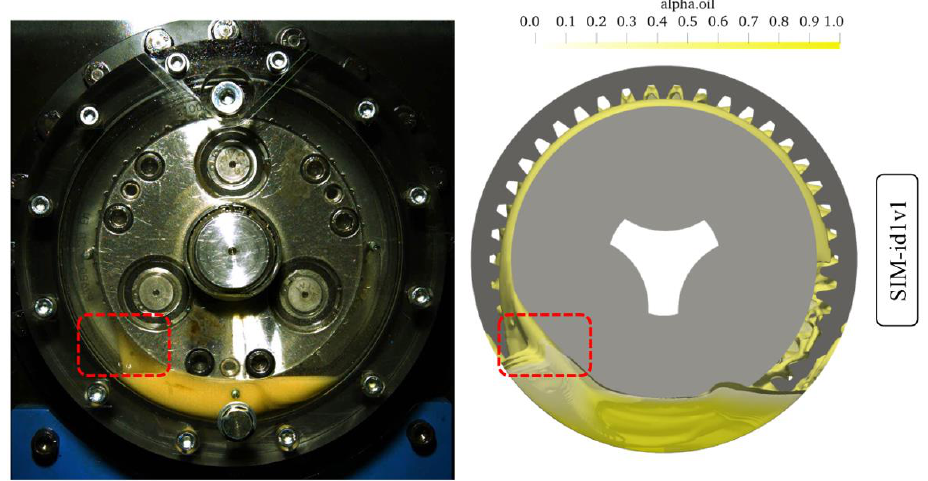
Figure 6. Experimental ( left ) and CFD ( right ) comparison of the oil flow for SIM-id1v1.